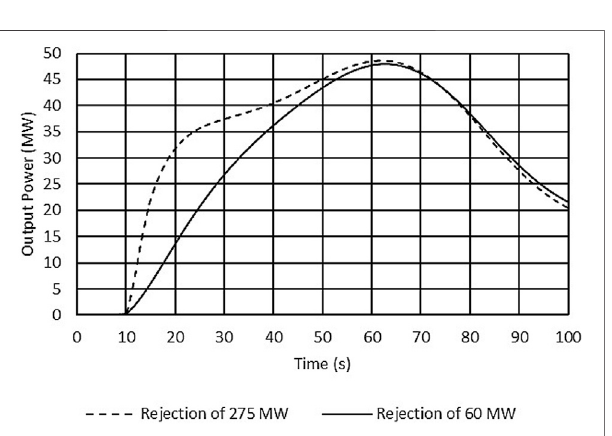
FIGURE 6 | Power rejection cycle of the battery bank.